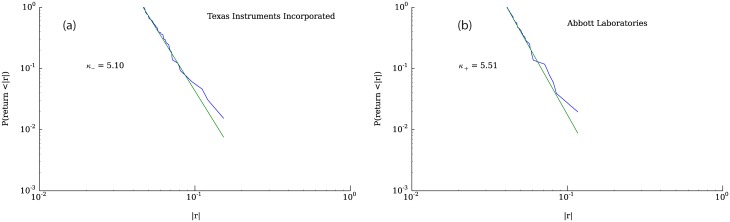
Powerlaw fits of two companies (Abbott Laboratories and Texas Instruments) with tail indexes greater than 3. Data obtained from QuantQuote [43].Fig (a) shows the negative returns and Fig (b) the positive returns.